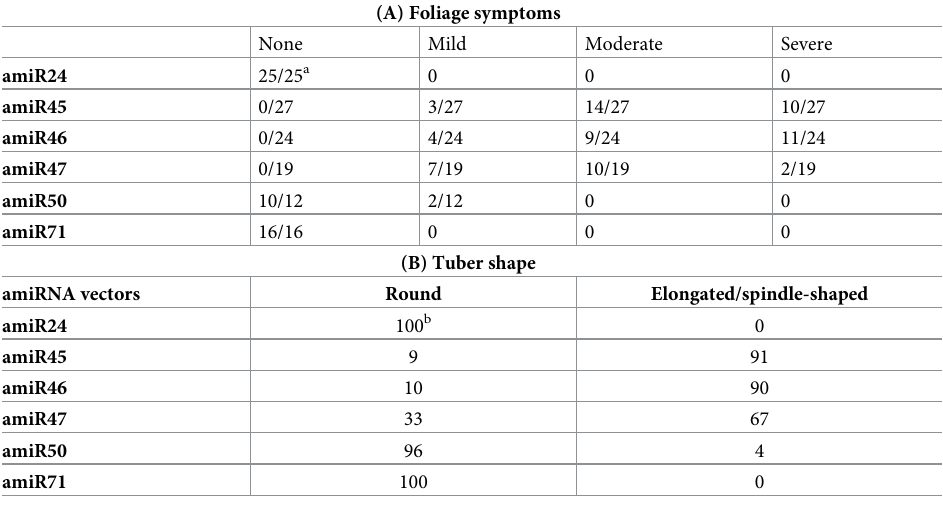
a Plants showing symptoms/total plants. b Data expressed as